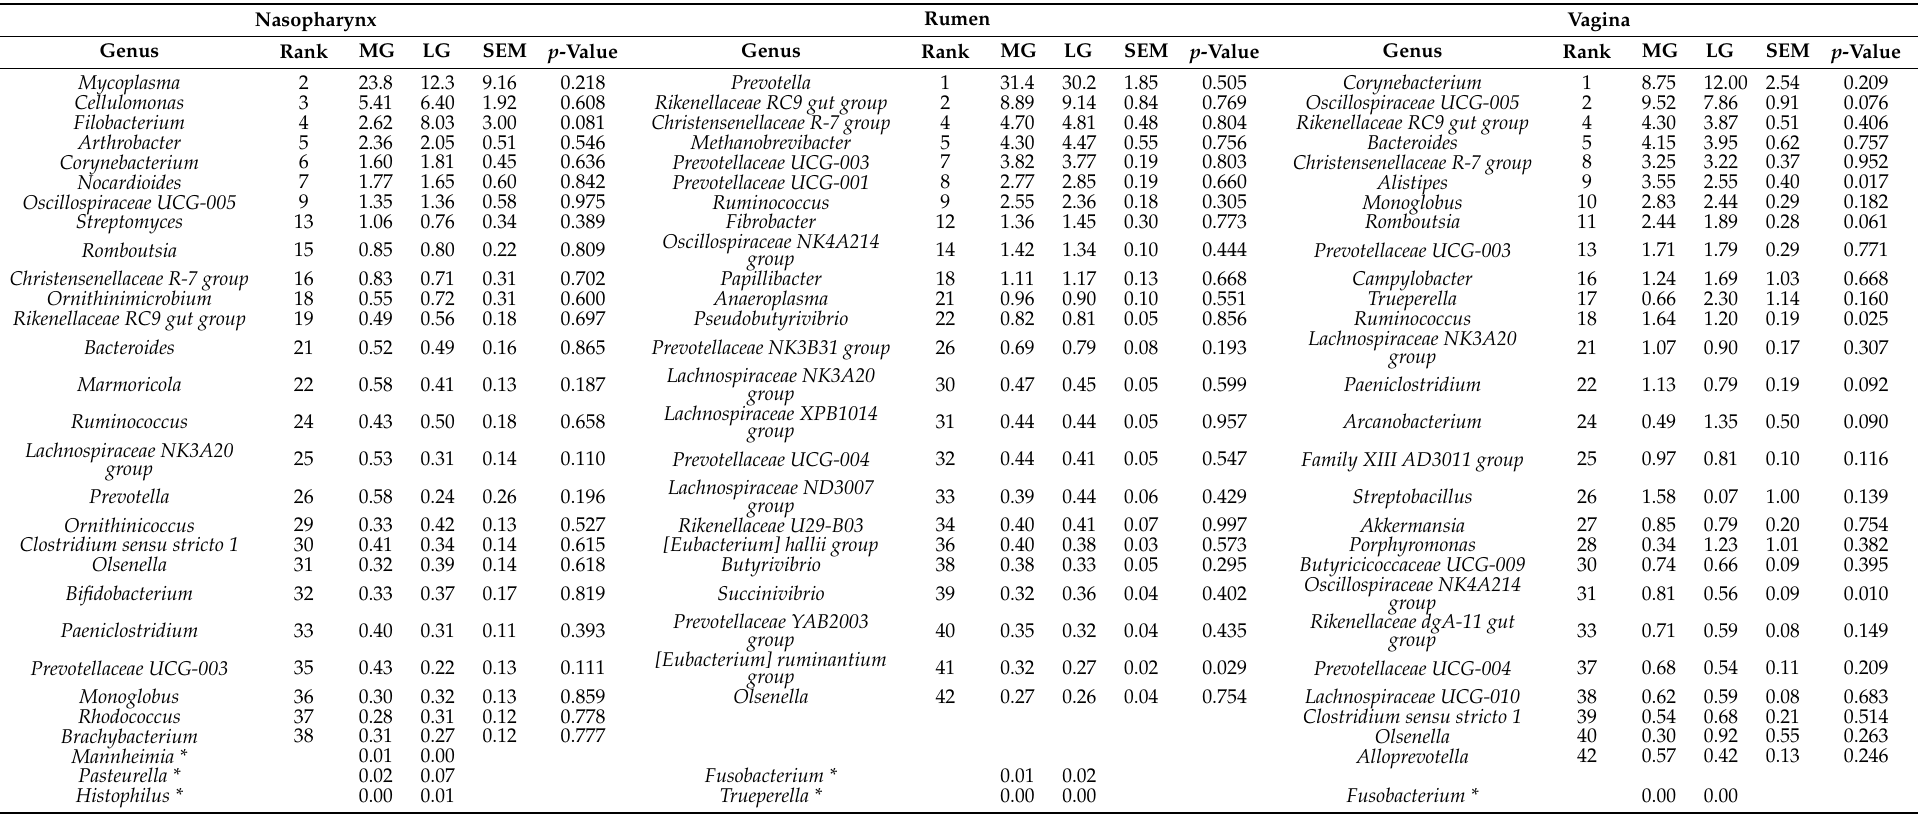
Table 2. Percent relative abundance of the most relatively abundant genera in nasopharyngeal ( n = 26), ruminal ( n = 24) and vaginal ( n = 27) microbiota of virgin yearling heifers that were born from the dams received a basal diet to achieve a moderate gain (MG) or to achieve a low gain (LG) during the first 84 days of gestation 1